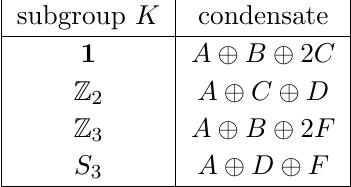
Table 1 . Condensed anyons corresponding to boundary subgroup K .